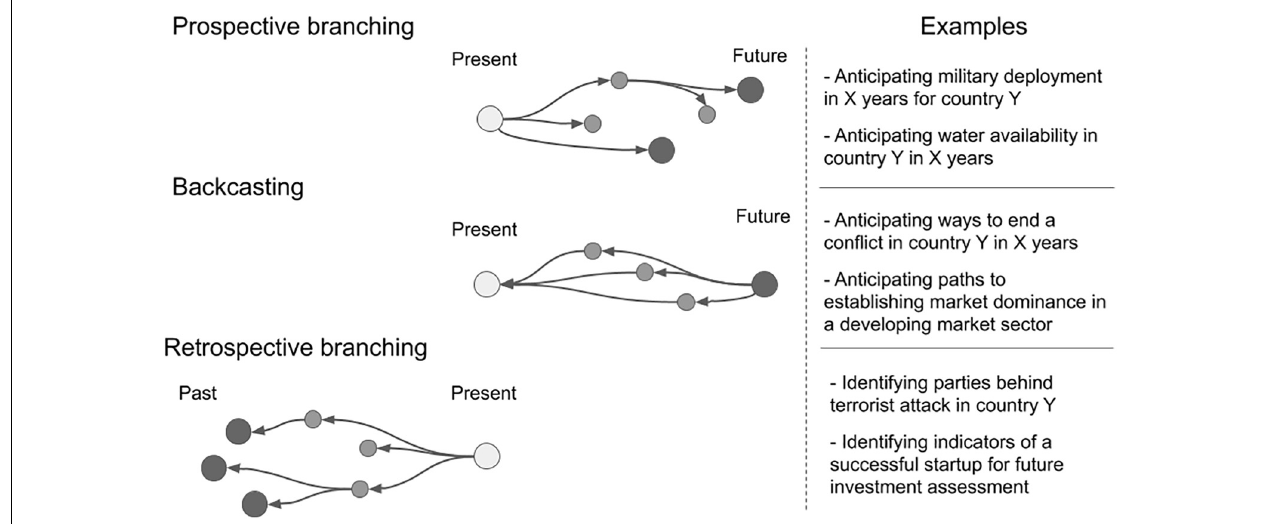
FIGURE 1 | Types of anticipatory thinking. Light gray circles represent the present, medium gray represent intermediate states, and dark gray represent states of interest. Arrows depict the direction in which the analyst is anticipating.